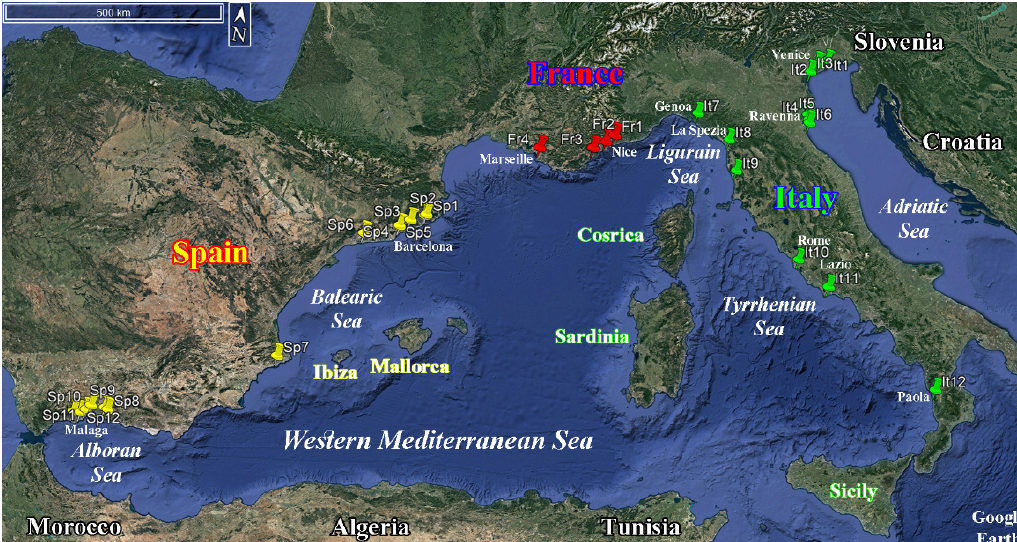
Figure 8. Selected beach nourishment sites along the Mediterranean coast of Spain (Sp1–Sp12), Italy (It1–It12) and France (Fr1–Fr4) (see Appendix A: Table A1).